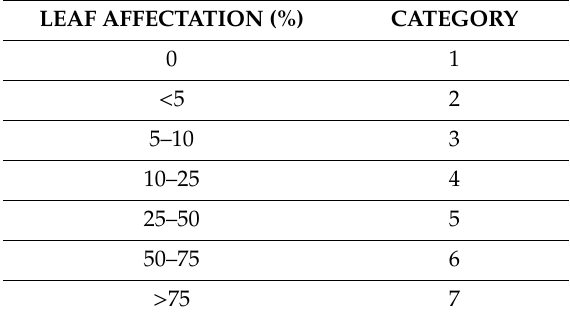
A ff ectation categories based on the percentage of leaves a ff ected, according to the EPPO guideline